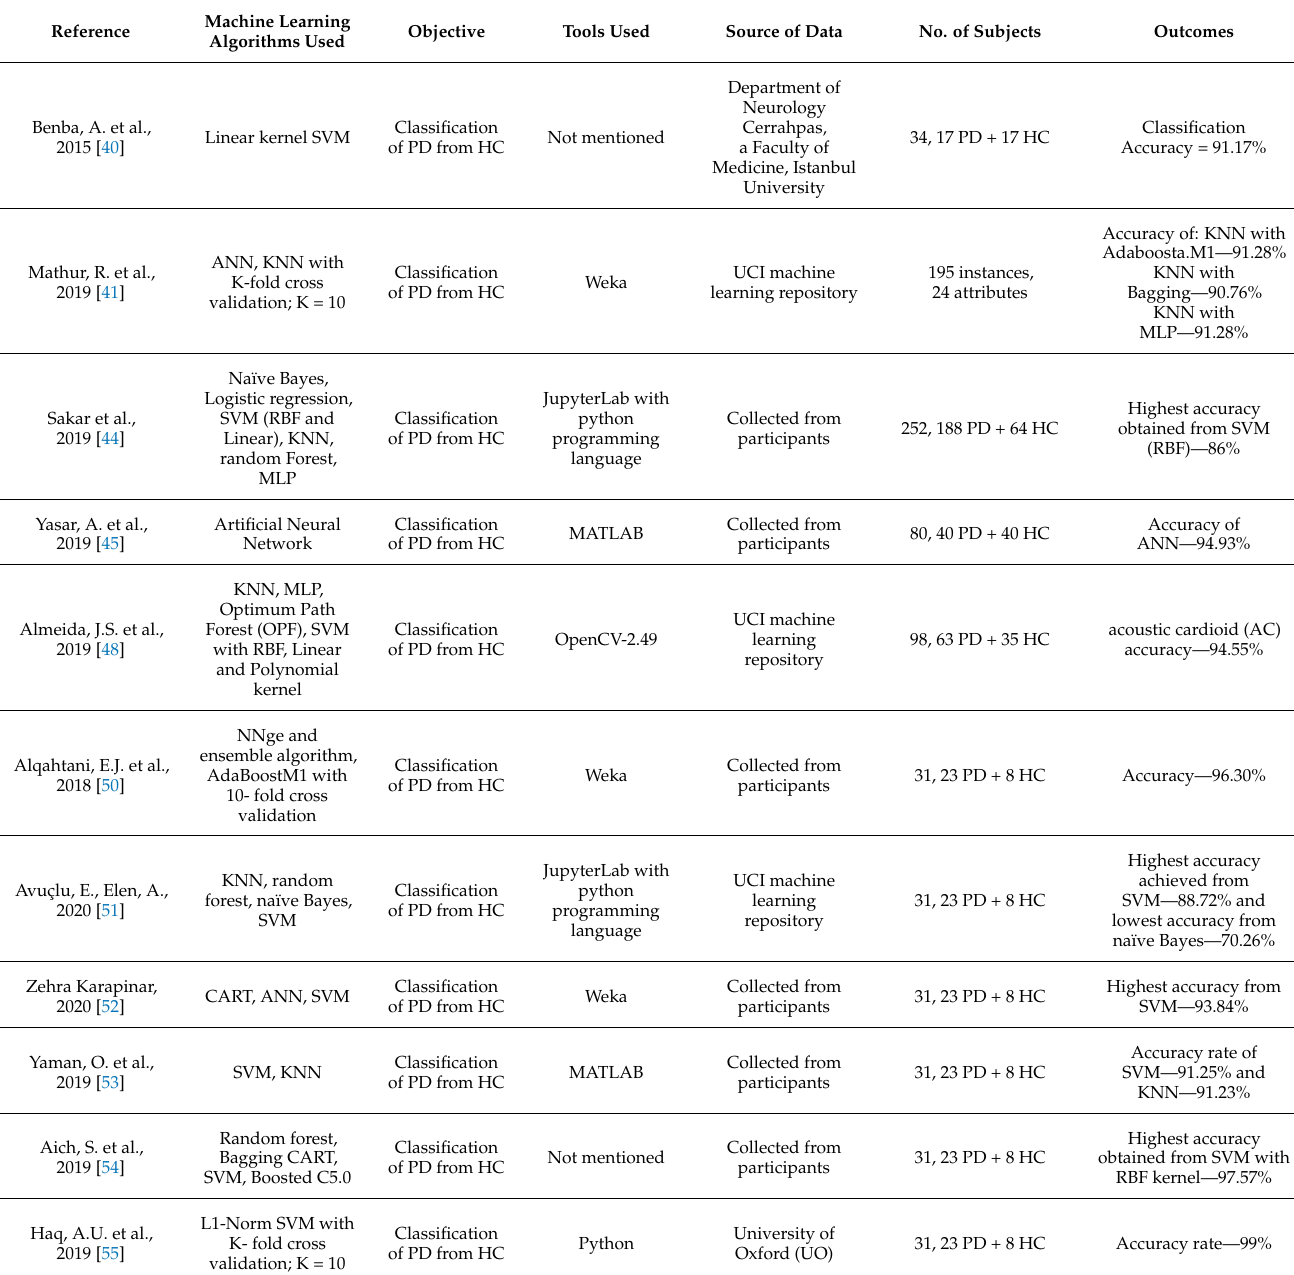
Table 1. Comparative studies of machine learning approaches in speech recording to diagnose